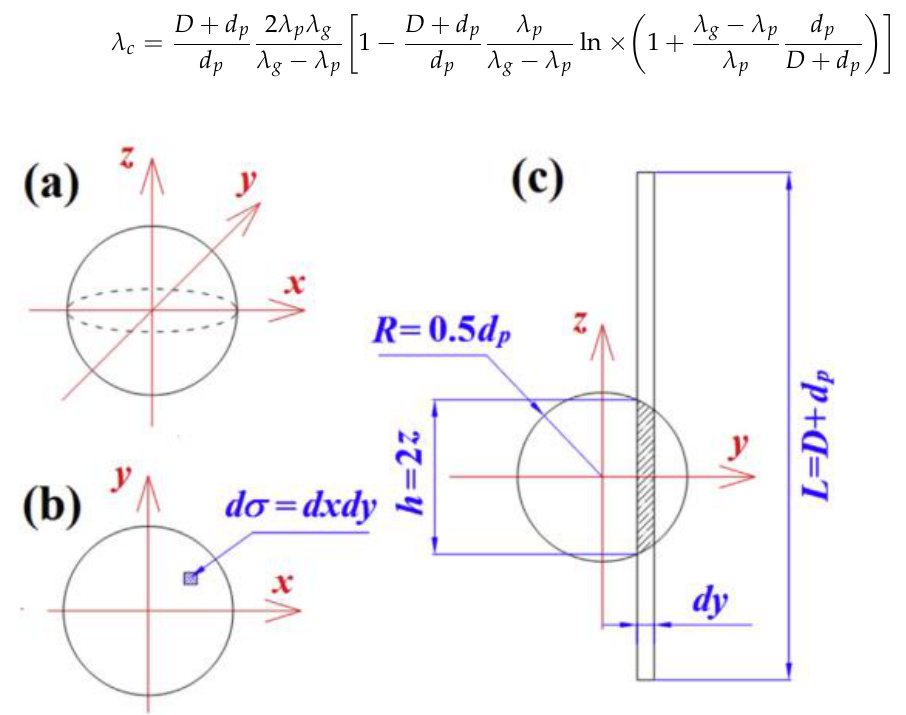
13 of 31 Figure 10. Gas-solid coupling thermal conductivity model established by Zhao et al. [25] ( a and i